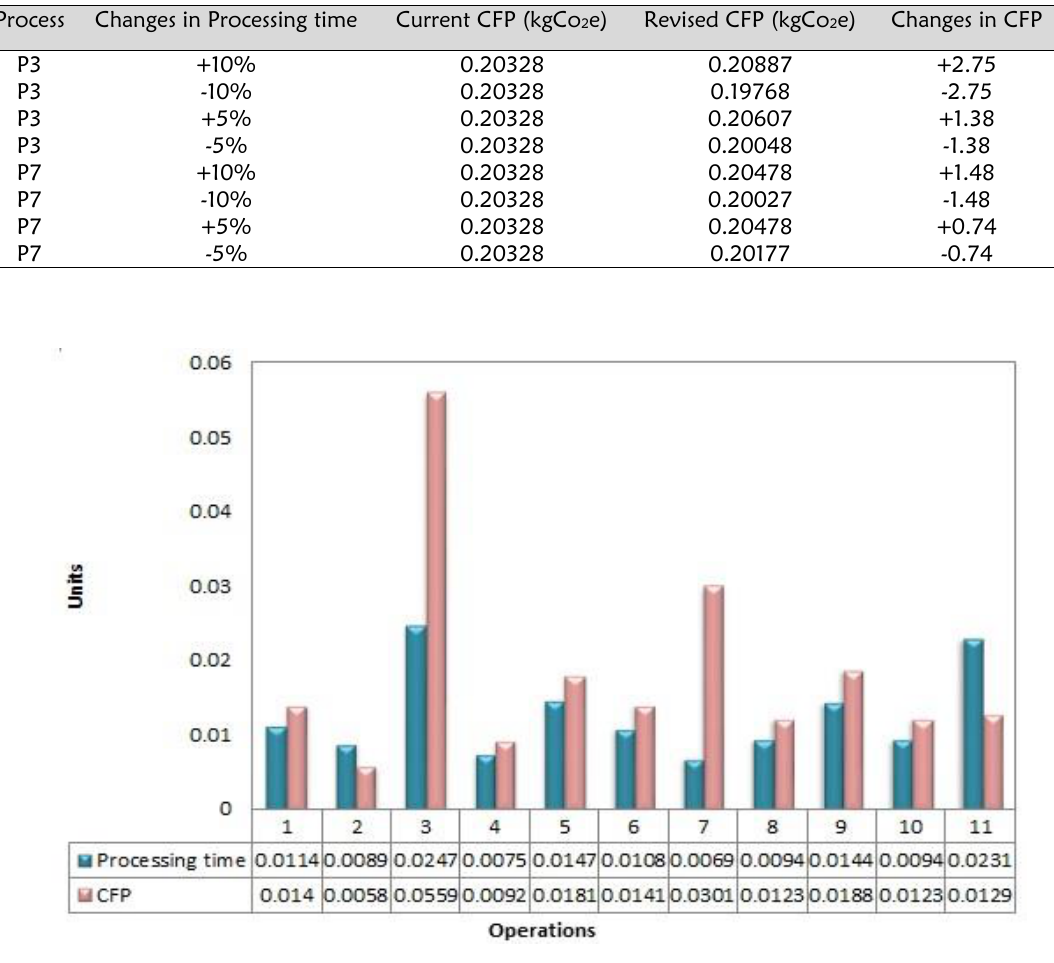
Figure 4: Changes in CFP values with respect to processing